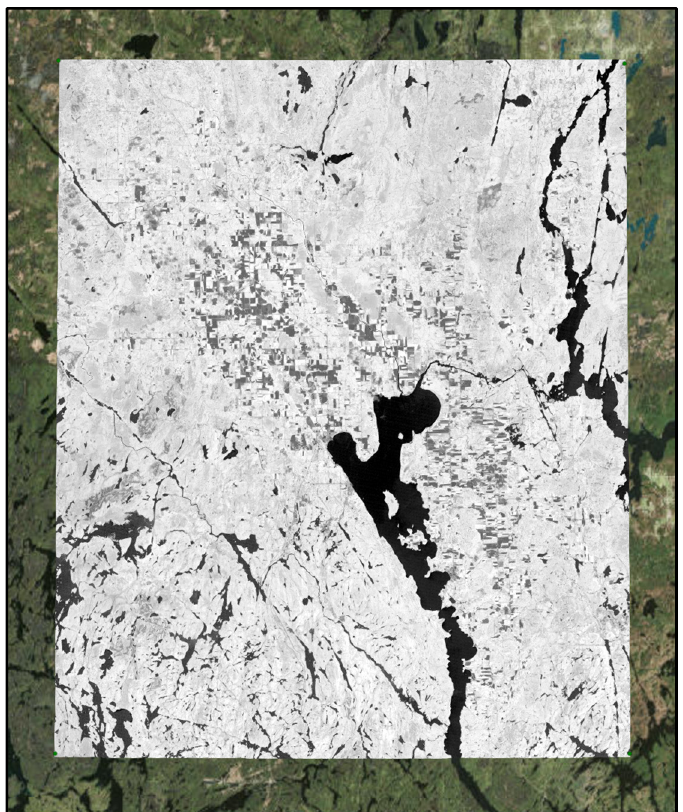
Figure 4. One of many current grey-scale Normalized Difference Vegetation Index (NDVI) images of Temiskaming Shores shown over the World Wind standard image globe (in colour). Bright tones are indicative of high biomass, or healthy crops, whereas dark tones indicate low biomass or no vegetative cover (e.g., lakes and rivers appearing as black).